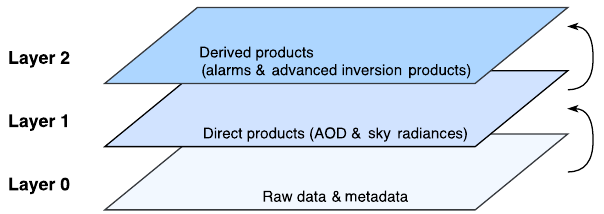
Figure 3. Different logic data layers. Each layer is based on the information of the previous